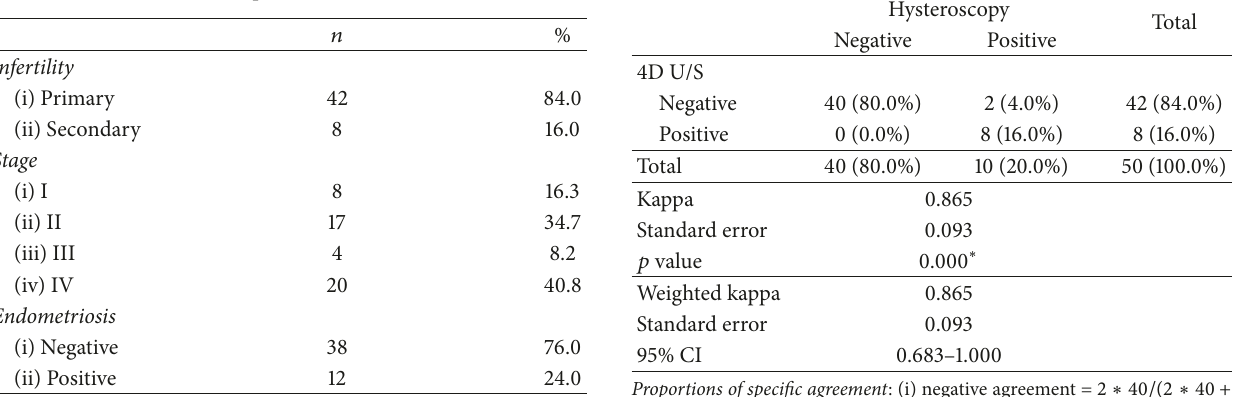
Table 1: Frequency of infertility and stage of endometriosis and endometrioma in the studied patients.